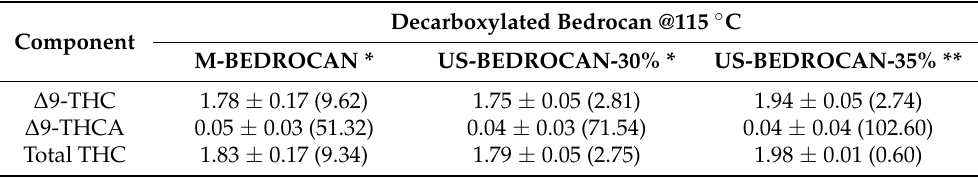
Table 6. Cannabinoids content expressed as % w/w (CV%) in samples prepared with decarboxylated Bedrocan after maceration and by UAE for 10 min, using 7 mm sonotrode (50 mL